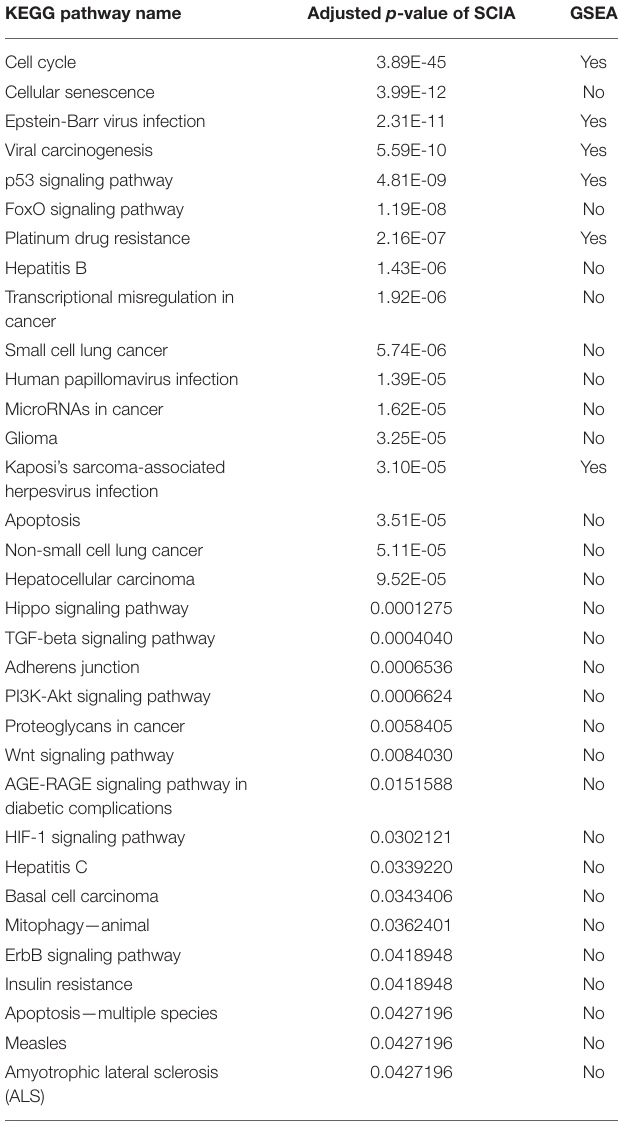
TABLE 5 | SCIA found more literature supported KEGG pathways than GSEA in two non-small-cell lung cancer datasets. KEGG pathway